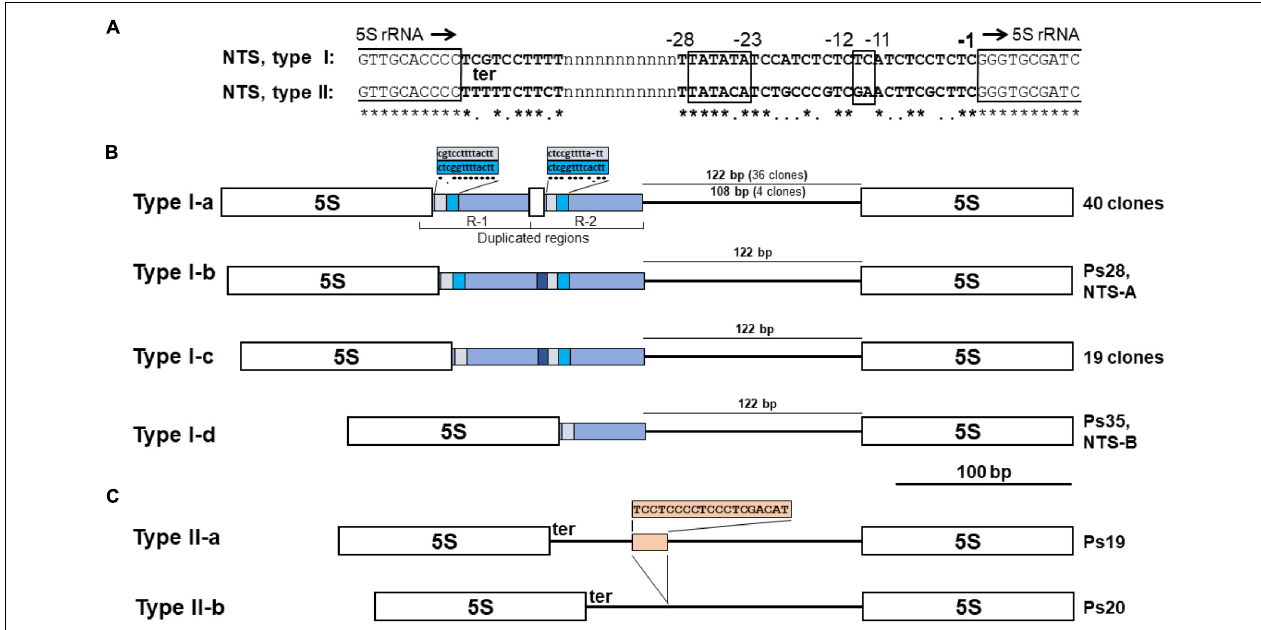
FIGURE 5 | NTS sequence variants of 5S rDNA in the genome of Pistia stratiotes . (A) Regulatory DNA elements downstream and upstream of the 5S rRNA genes. The end and beginning of 5S rRNA genes are marked by open boxes. Position -1 marks the first nucleotide upstream of the 5S rDNA transcription start; black arrows indicate the direction of gene transcription. ter , transcription terminator. The boxed nucleotide position -11 to -12 marks the usual location of the GC dinucleotide; positions -23 to -28 mark the TATA-like motif. (B) Schematic representation of 5S rDNA units with Type I NTSs. Open boxes define the sequences of 5S rRNA genes. (C) Schematic representation of 5S rDNA units with Type II NTSs. Open boxes define the sequences of 5S rRNA